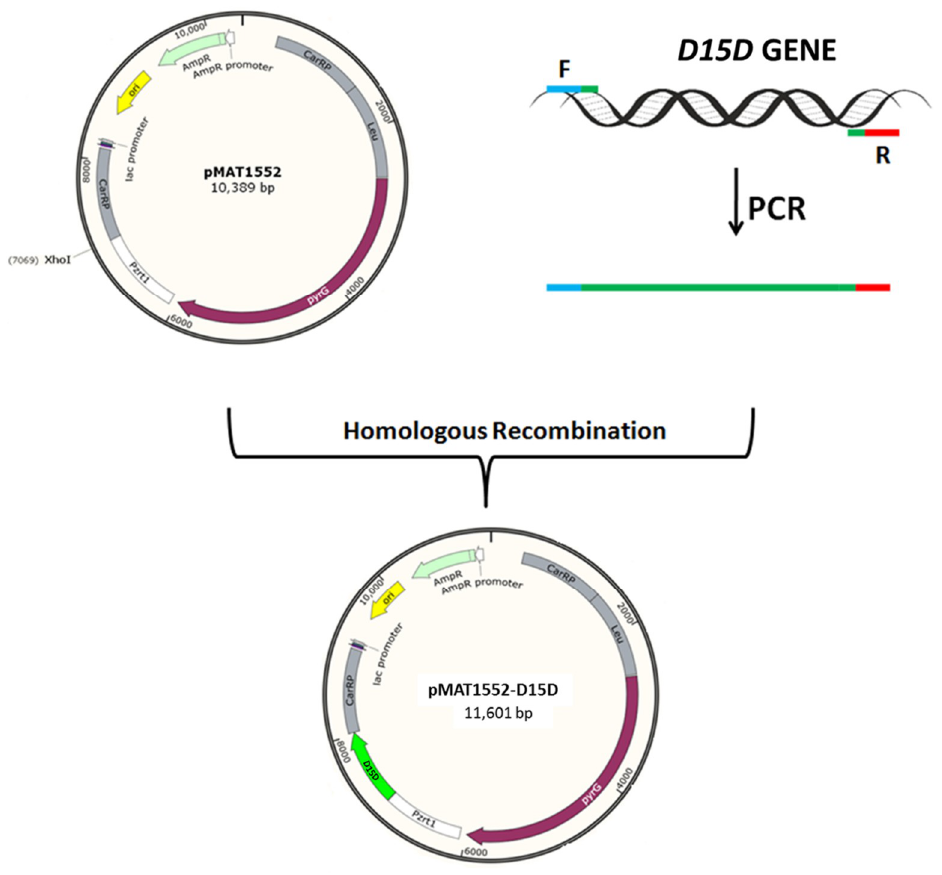
Figure 5. The structure of plasmids pMAT1552 and pMAT1552-D15D. The D15D gene was isolated by PCR amplification with appropriate primers. The PCR fragment was ligated into XhoI restriction site to generate plasmid as